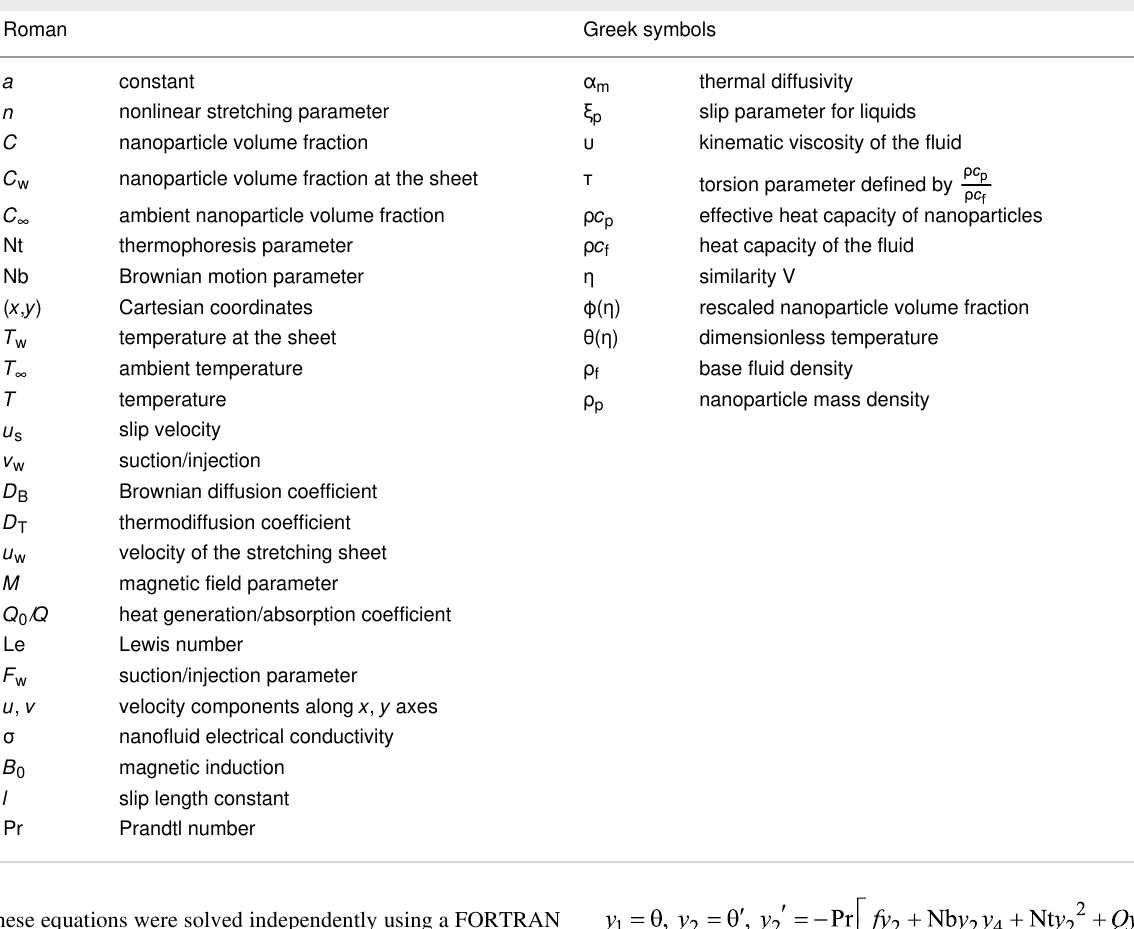
Table 1: Nomenclature for the basic nanofluid governing equations. Roman Greek